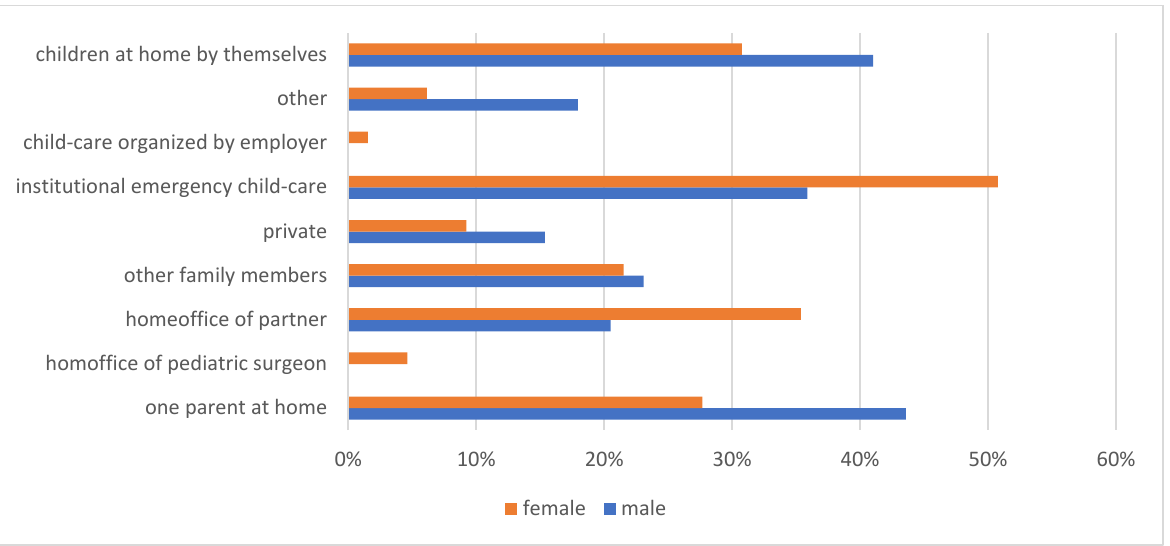
Figure 4. Childcare in families with underage children during the lockdown (differences were not significant).